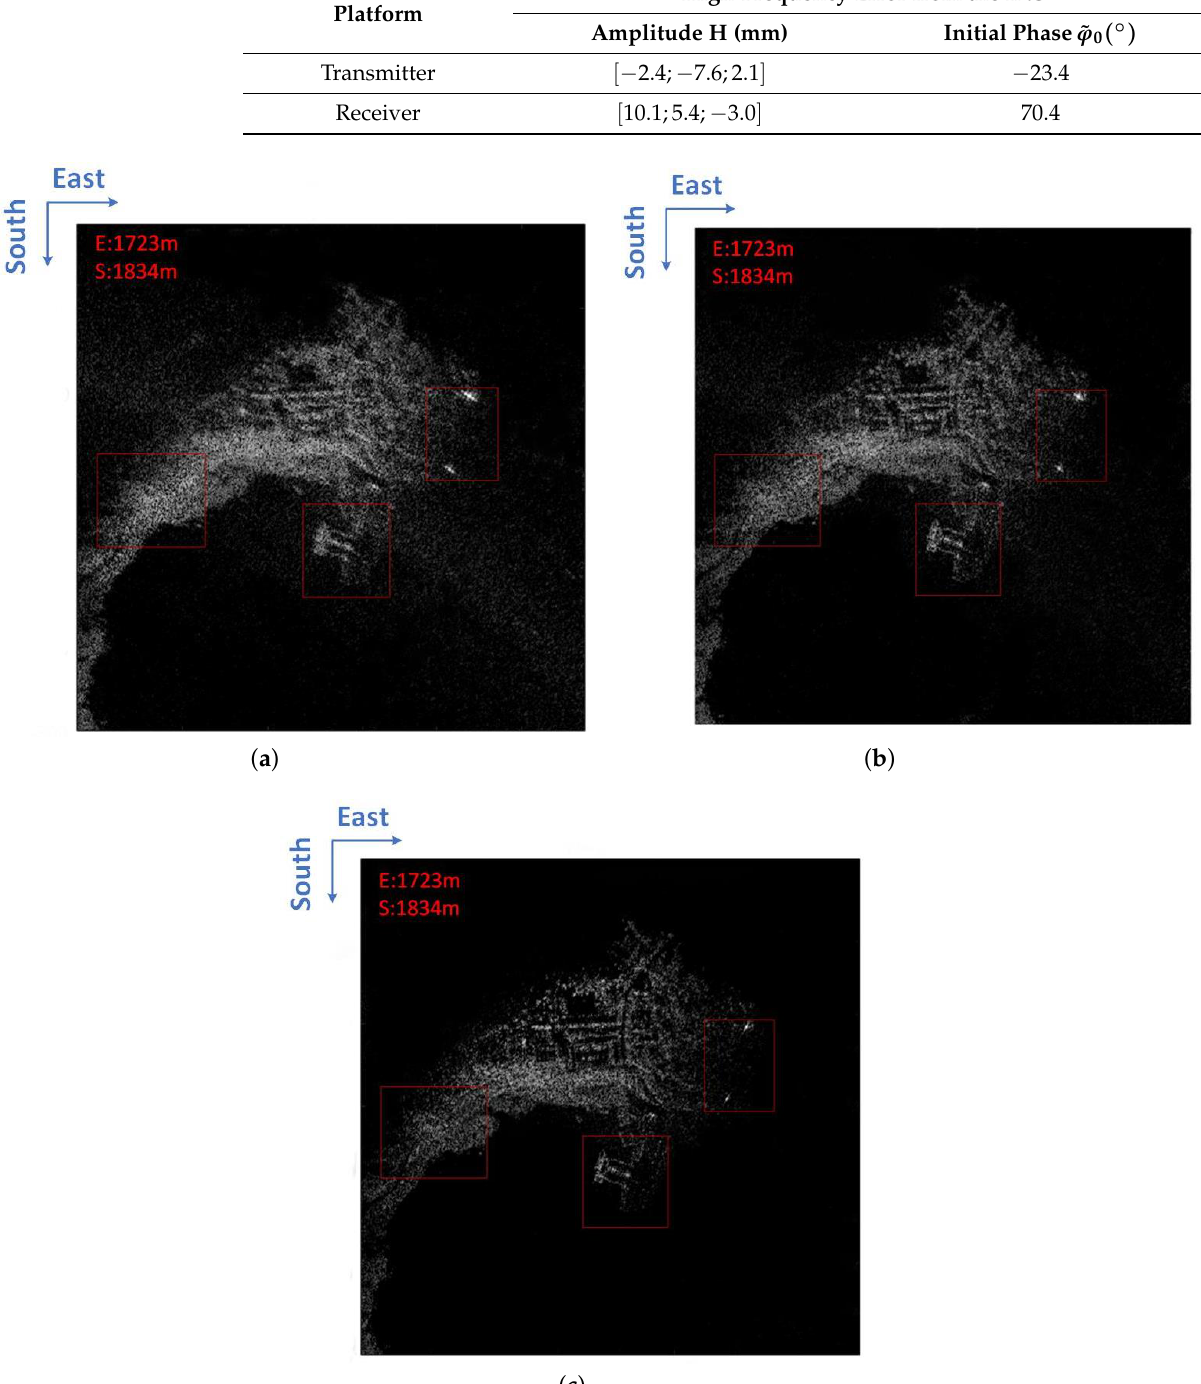
Figure 13. Image results of different MOCO algorithms. ( a ) is the image result without MOCO. ( b ) is the image result with traditional MOCO algorithm [11,23]. ( c ) is the result with proposed MOCO